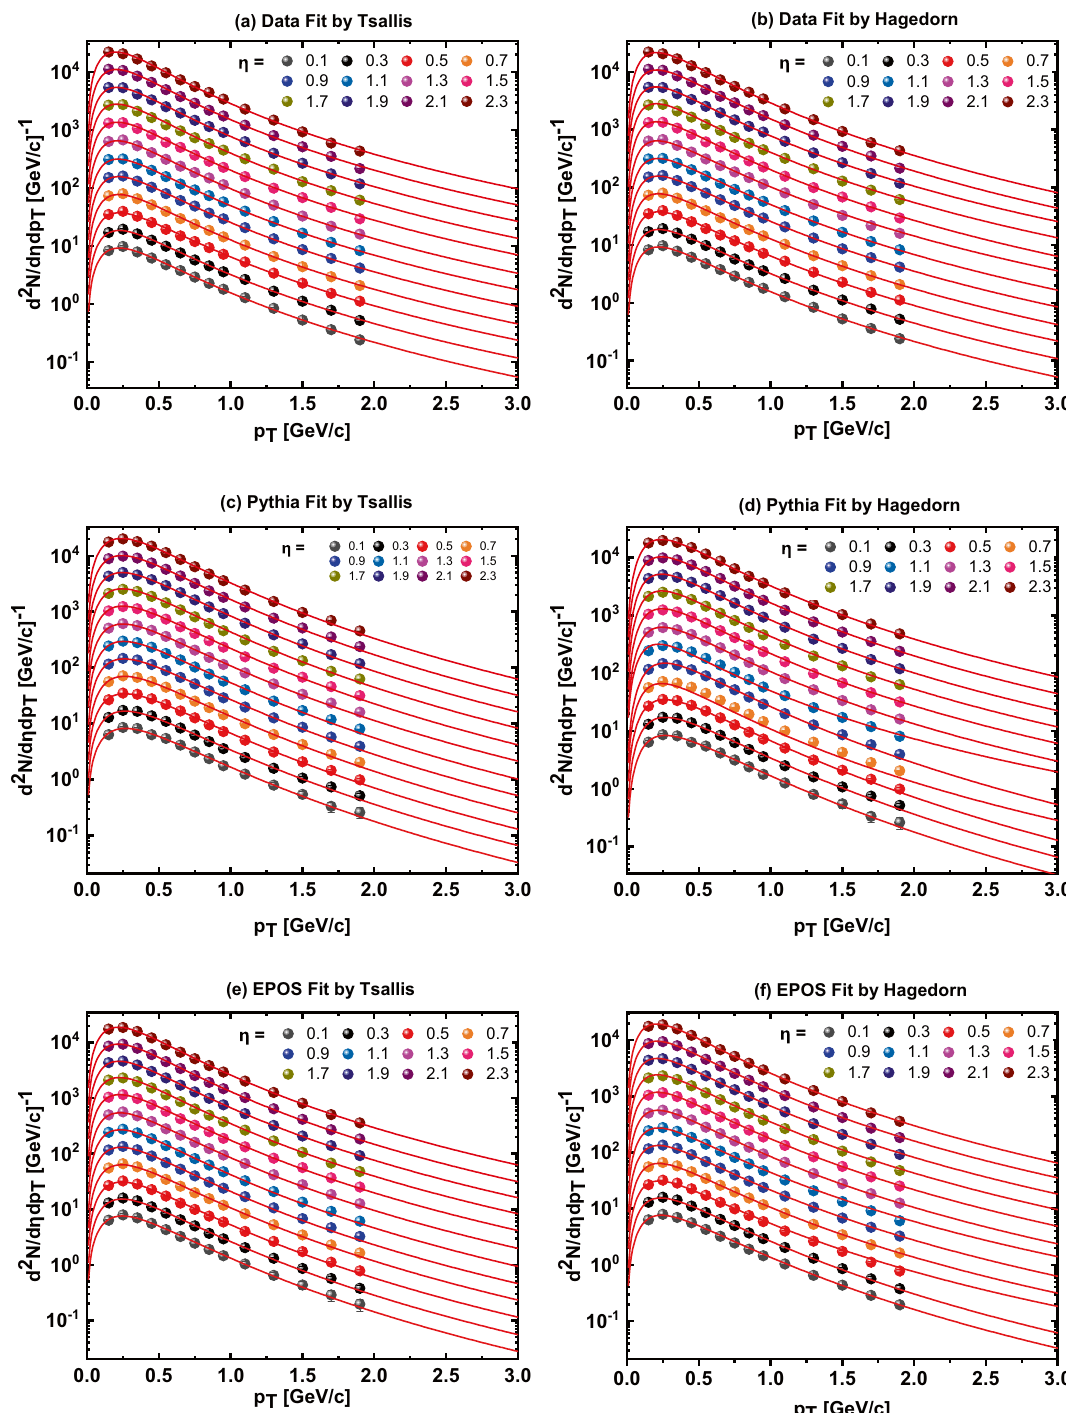
Figure 4. The charged hadrons p T spectra in different η intervals from 0 to 2.4 in steps of 0.2 measured by the CMS experiment is fitted with the Tsallis function (Eq. 7) (left) and Hagedorn function (Eq. 8) (right) shown in the first row ( a and b ). Same markers with different colors are used to represent each slice of η bin. Lines of the same color are used to show the fit results on the experimental data. The second ( c and d ) and third ( e and f ) rows show the Pythia and EPOS simulations fitted with the Tsallis (left) and Hagedorn (right) functions,